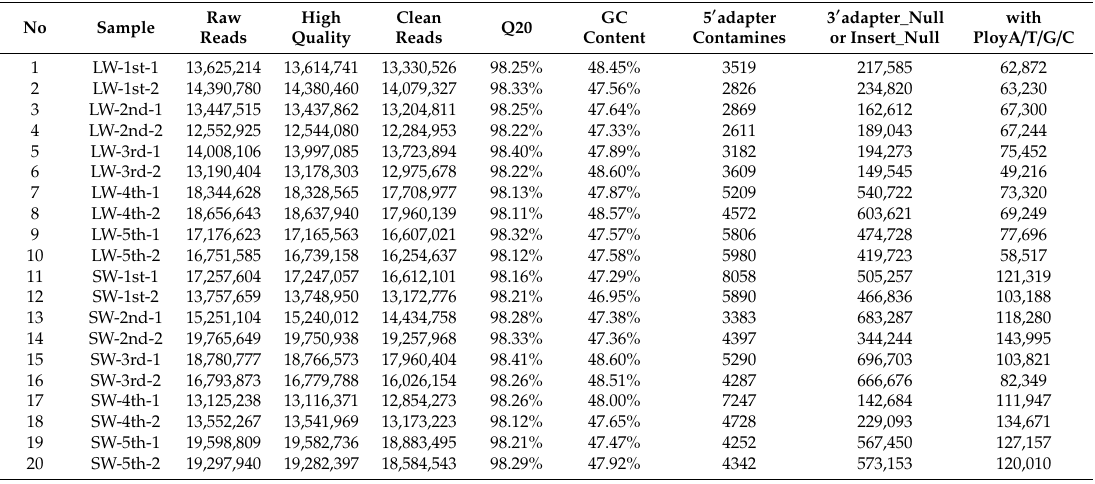
Table 1. Reads obtained from small RNA libraries sequenced in Nilaparvata lugens